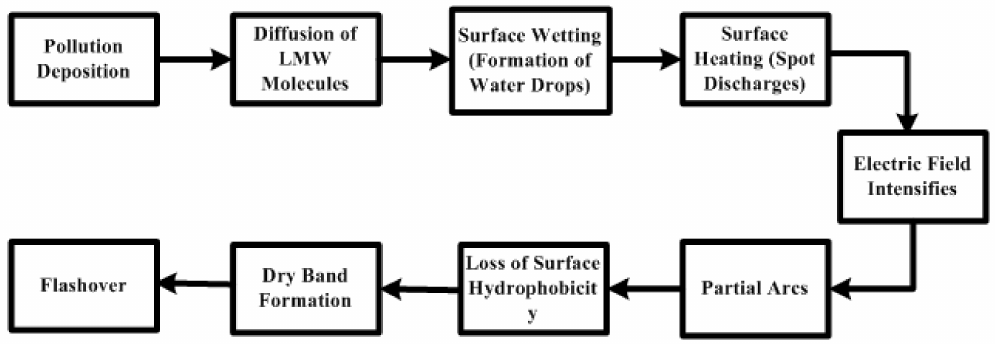
Figure 1. Flashover process of silicone rubber outdoor